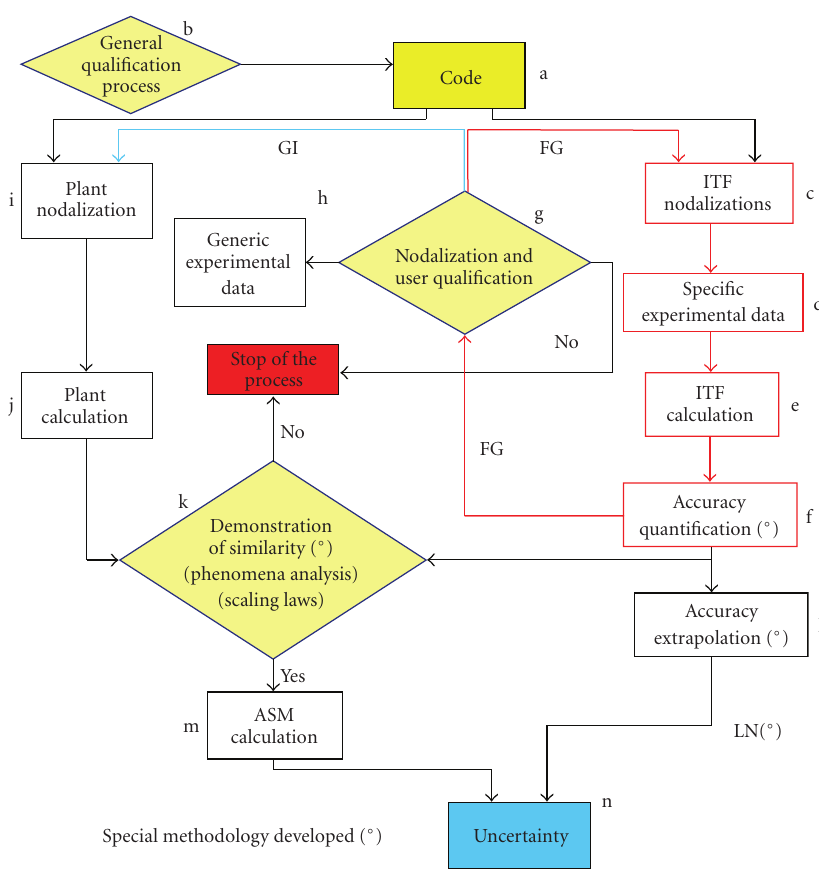
Figure 3: The flow-diagram of UMAE.